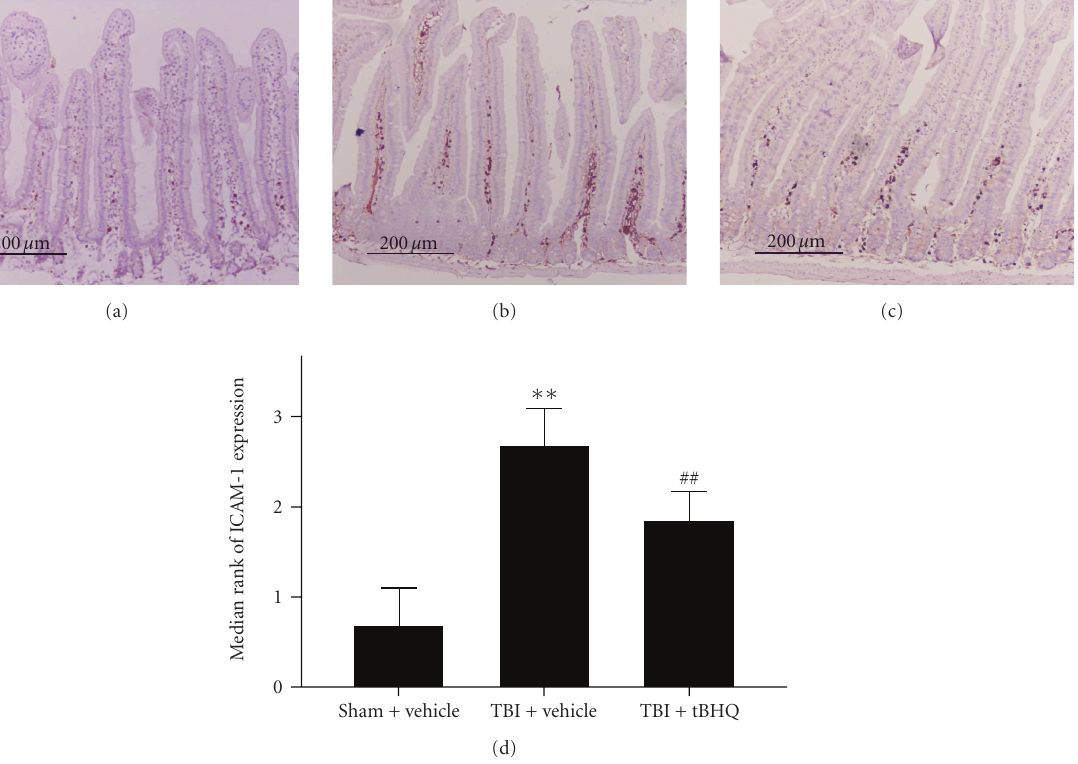
Figure 3: Expression of ICAM-1 in the intestinal tissue in sham + vehicle group, TBI + vehicle group, and TBI + tBHQ group ( n = 6). (a) Sham + vehicle group mice showing low ICAM-1 immunoreactivity. (b) TBI + vehicle group showing increased ICAM-1 immunoreactivity. (c) TBI + tBHQ group mice showing less ICAM-1 immunoreactivity than those of TBI + vehicle group. (d) tBHQ administration significantly downregulated the ICAM-1 expression in mice gut following TBI. ∗∗ P < . 01 versus sham + vehicle group; ## P < . 01 versus TBI + vehicle